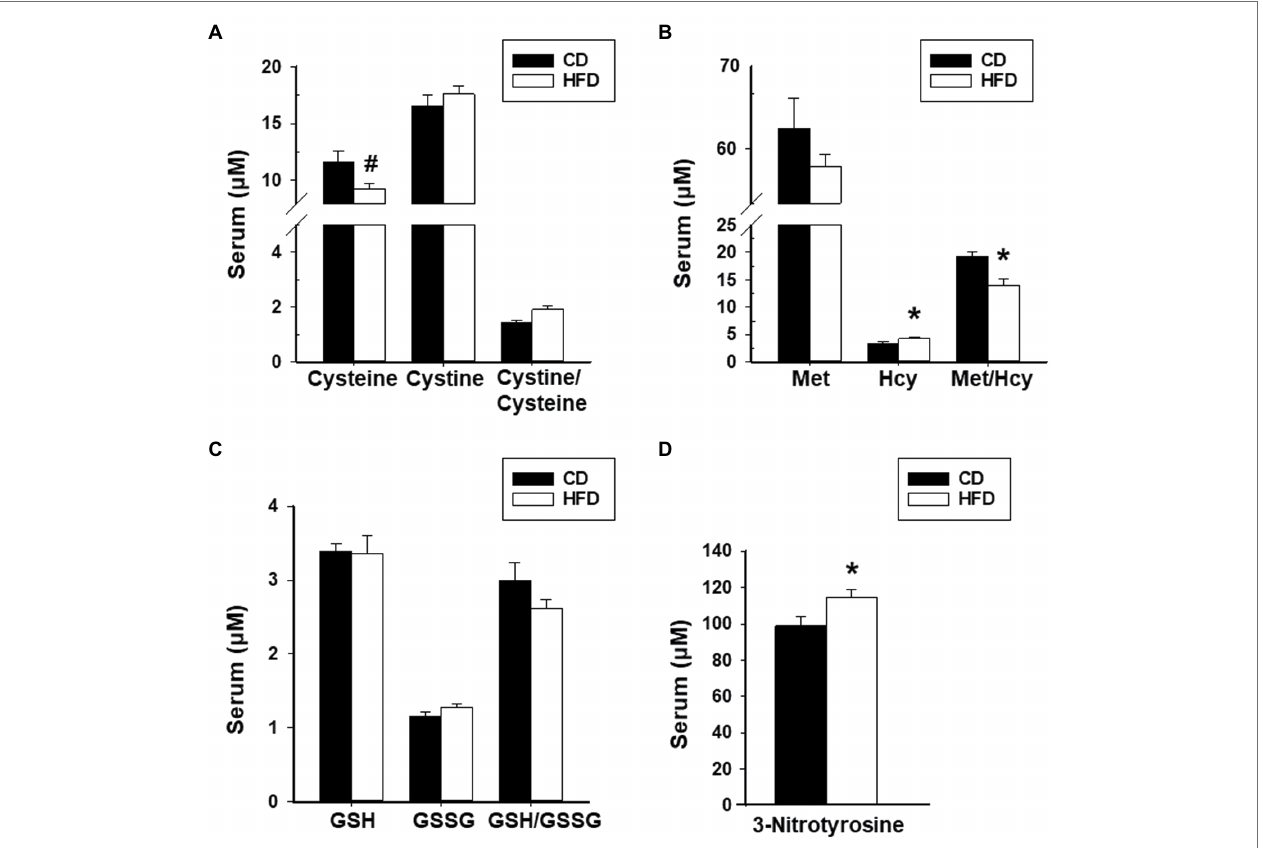
FIGURE 4 | HFD effects on levels of serum oxidants and anti-oxidants and their ratios in recipient mice with lesions. (A) Cysteine, Cystine, and Cystine/Cysteine ratio; (B) Methionine, Homocysteine, and Methionine/Homocysteine ratio; (C) Glutathione, Glutathione disulfide, and Glutathione/Glutathione disulfide ratio; and (D) 3-Nitrotyrosine. Data (mean ± SEM) are from n = 7 (CD) and n = 6 (HFD) mice per diet group. * p < 0.05 and # 0.10 < p < 0.05 by Student’s t-